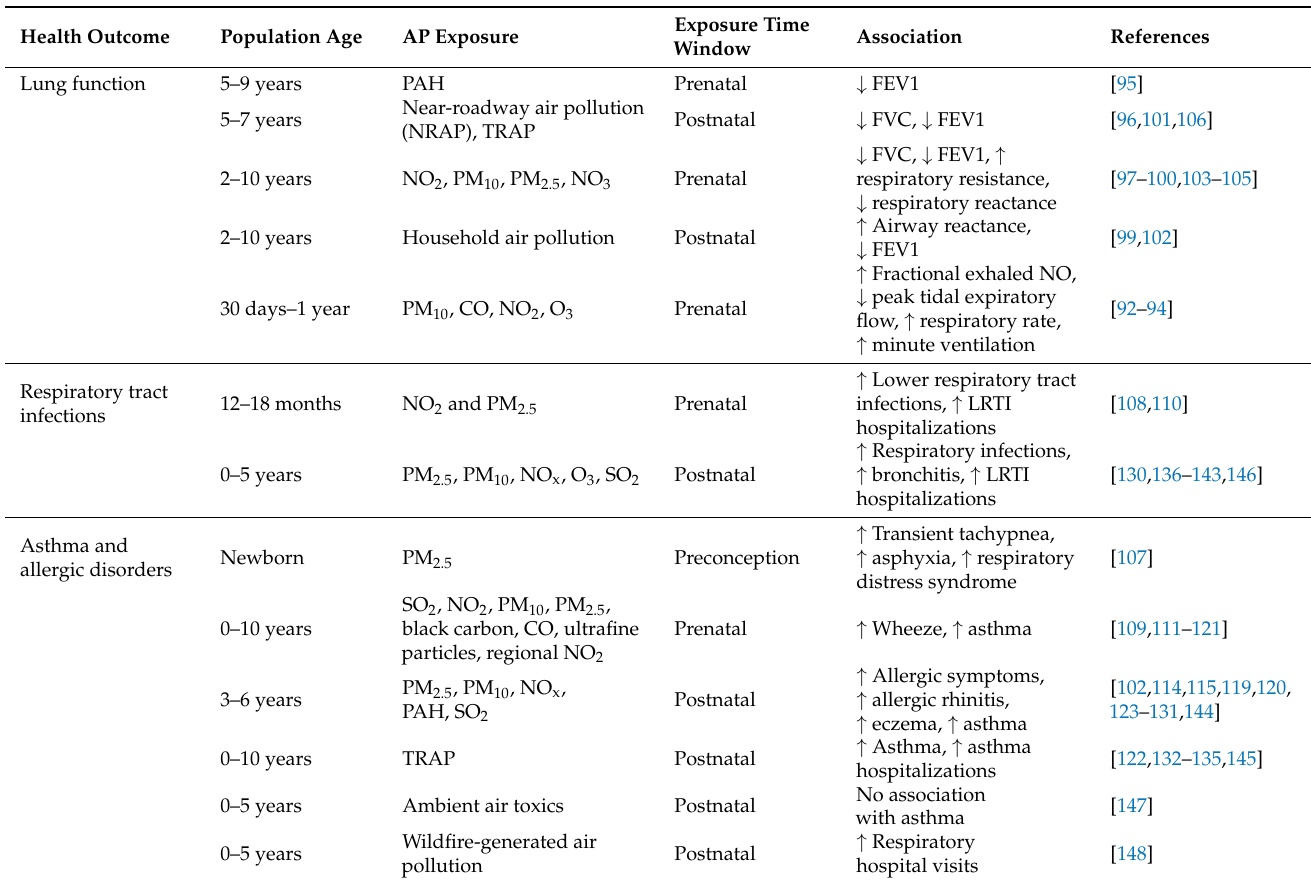
Table 2. Respiratory and Allergic Outcomes Associated with Early-Life Air Pollution